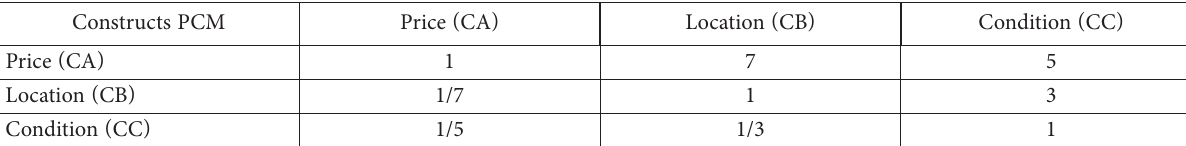
Table 3. A pairwise comparison matrix for the constructs using a respondent’s data as an